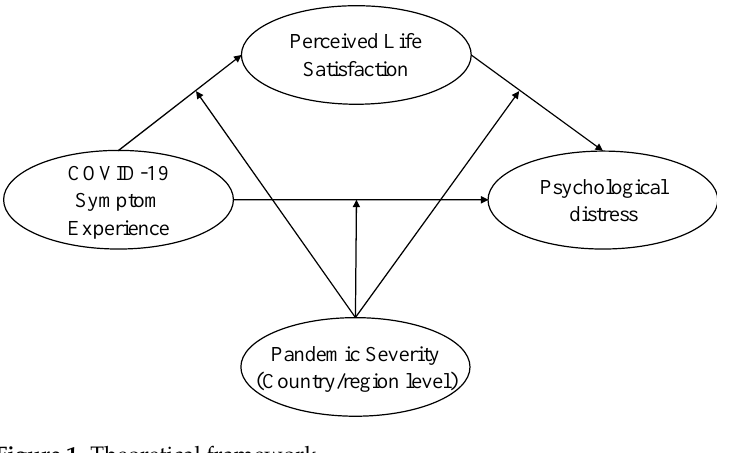
Figure 1. Theoretical framework.